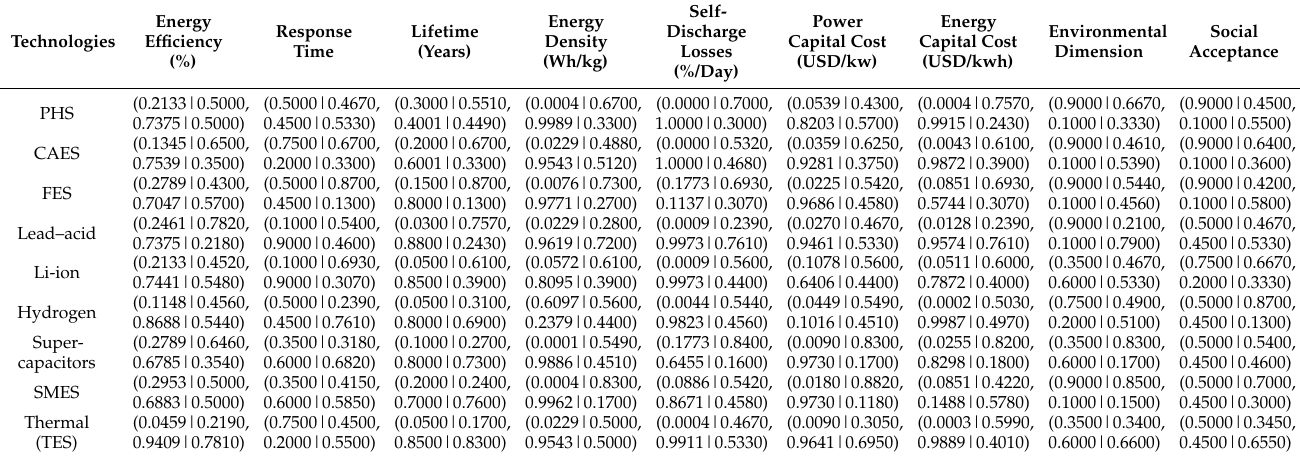
Table A16. Initial decision matrix of Expert